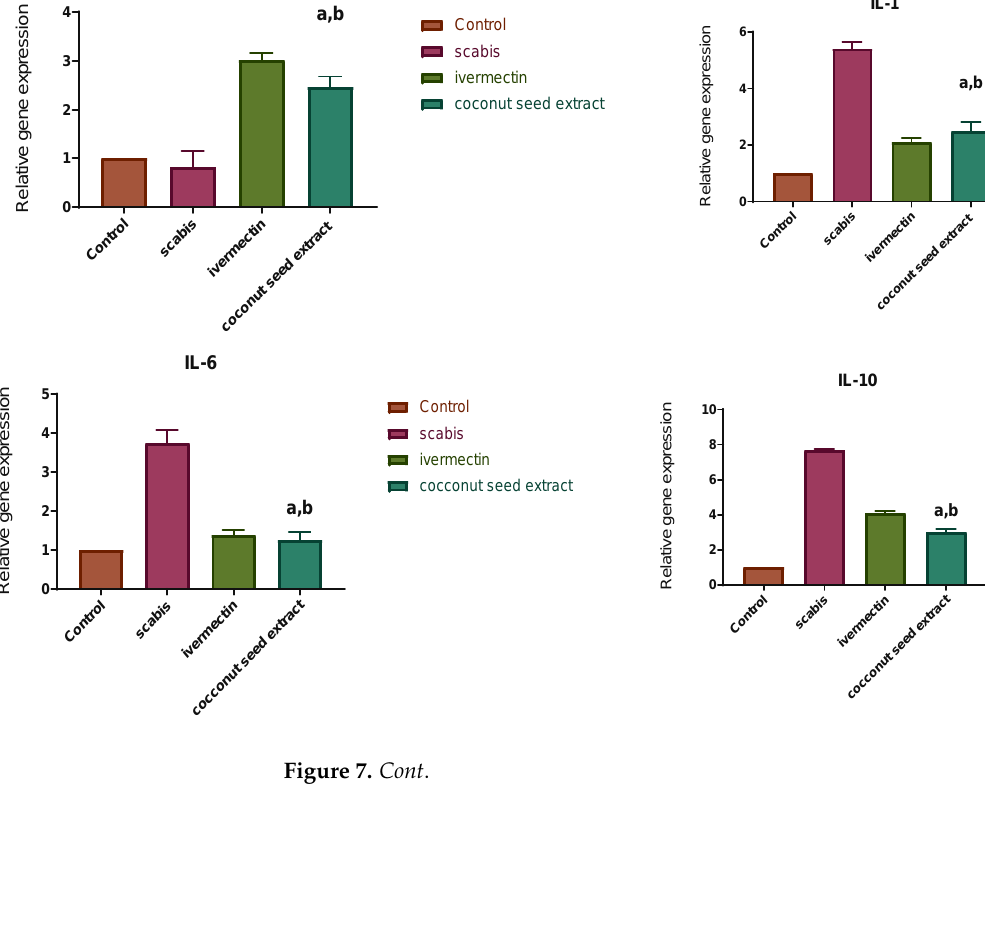
Figure 6. Microscopical examination of skin from different groups of animals. ( A ) normal group showing normal architecture of the skin: e—epidermis, d—dermis, and h.f.—hair follicles; ( B ) pos- itive control group showing skin damage with hyperkeratosis (red arrows), mites at different stages embedded in the skin (blue arrows), hypergranulation of the dermis (green arrows), and severe akanthosis with cellular infiltration (black arrows); and ( C ) coconut seed extract group showing restoration of normal architecture, with only mild cellular infiltration (red arrow). Healthy seba- ceous glands (yellow arrow) and hair follicles (black arrows); ( D ) ivermectin group showing mod- erate damage with hyperkeratosis (red arrow), mature mites with eggs still embedded in the dermis (black arrow) surrounded by cellular infiltration (green arrow), and some sebaceous adenitis (yellow arrows).